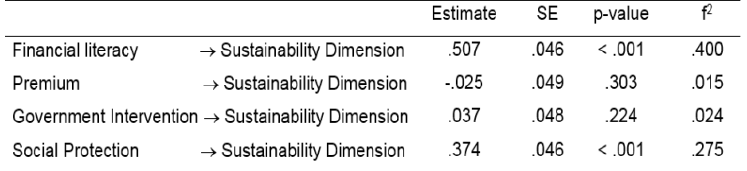
Table 6: The Effect of Social Cultural Beliefs on the Perception of the Respondents on Microinsurance